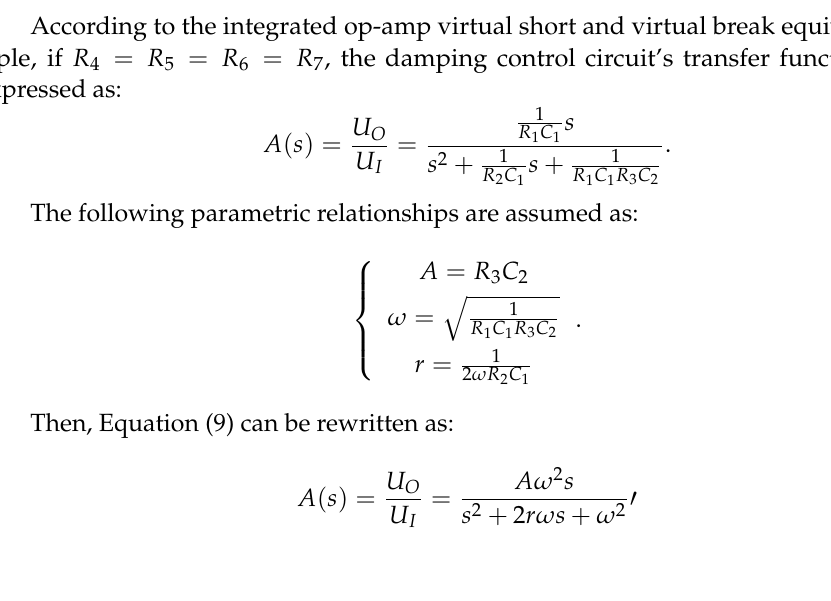
Figure 6. Damping control circuit.